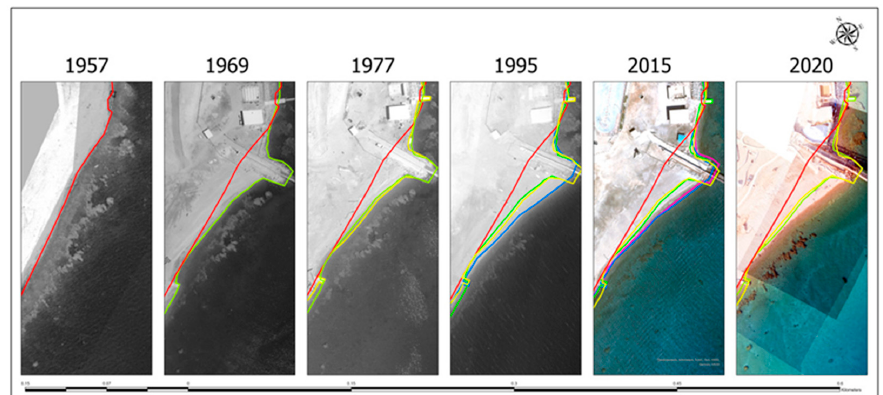
Figure 5. Historical serial images from the years 1957–2015, and a drone image from 2020, over the area of Pier One (region 6 in Figure 1). Red, Green, Yellow, Blue, and Purple lines delineate the shoreline as identified in the 1957, 1969, 1977, 1995, and 2015 images, respectively.